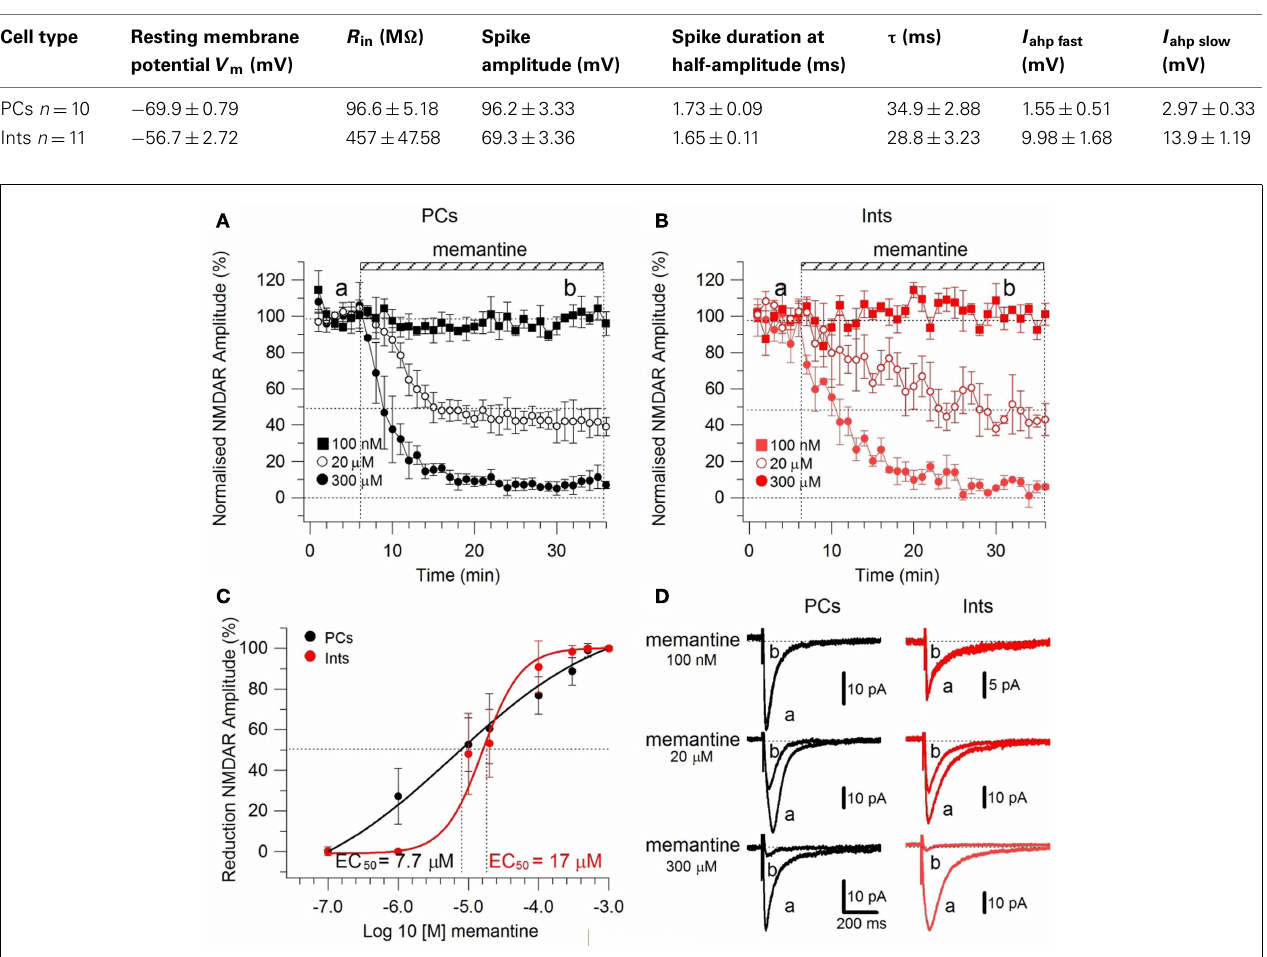
Table 1 | Electrophysiological properties of CA1 PCs and Ints.